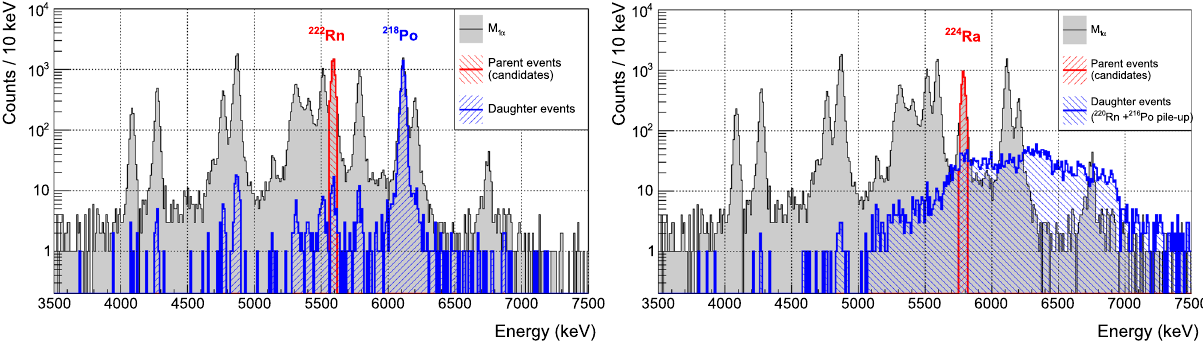
Fig. 2 Search for delayed coincidences in the 238 U (left) and 232 Th (right) decay chains. The grey spectrum comprises the not piled-up α events. We tag as daughter (blue) all the events within a 5 T M 1 time-window after a candidate parent event recorded at the 222 Rn (left)